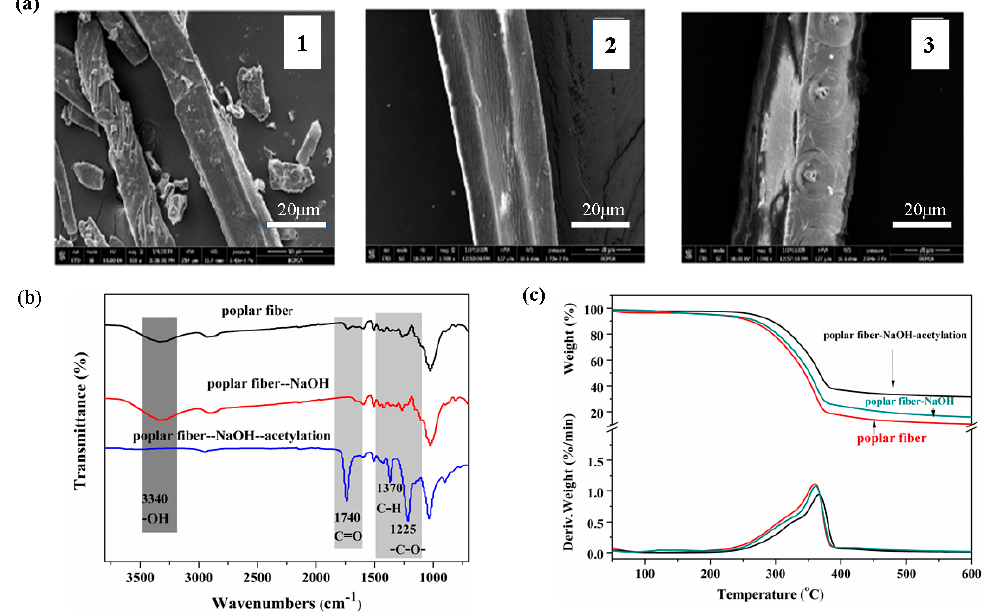
Figure 1. ( a ) SEM figures of poplar fibers: (1) Poplar fiber, (2) poplar fiber-NaOH, and (3) poplar fiber-NaOH-acetylation. ( b ) FTIR spectra of poplar fibers. ( c ) TGA and DTG curves of poplar fibers.